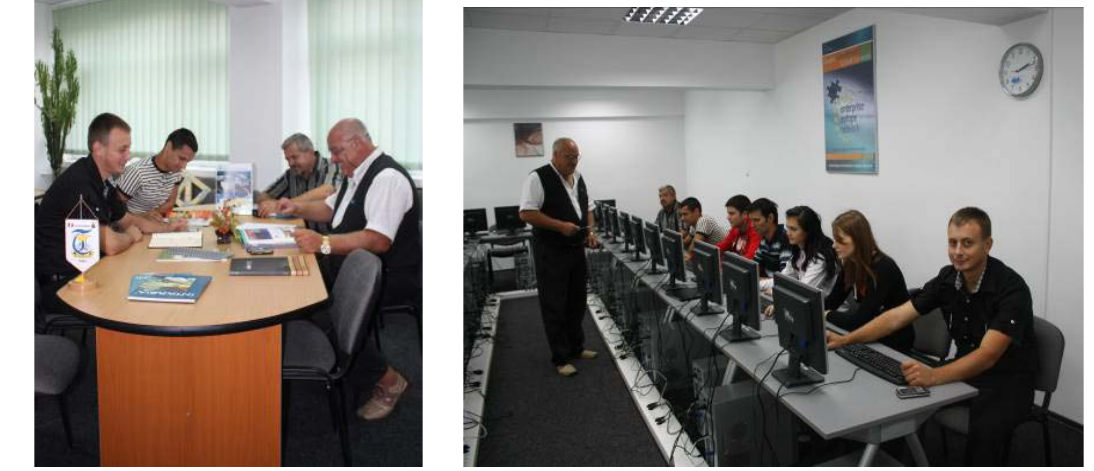
Figure 6. “Teaching and meeting